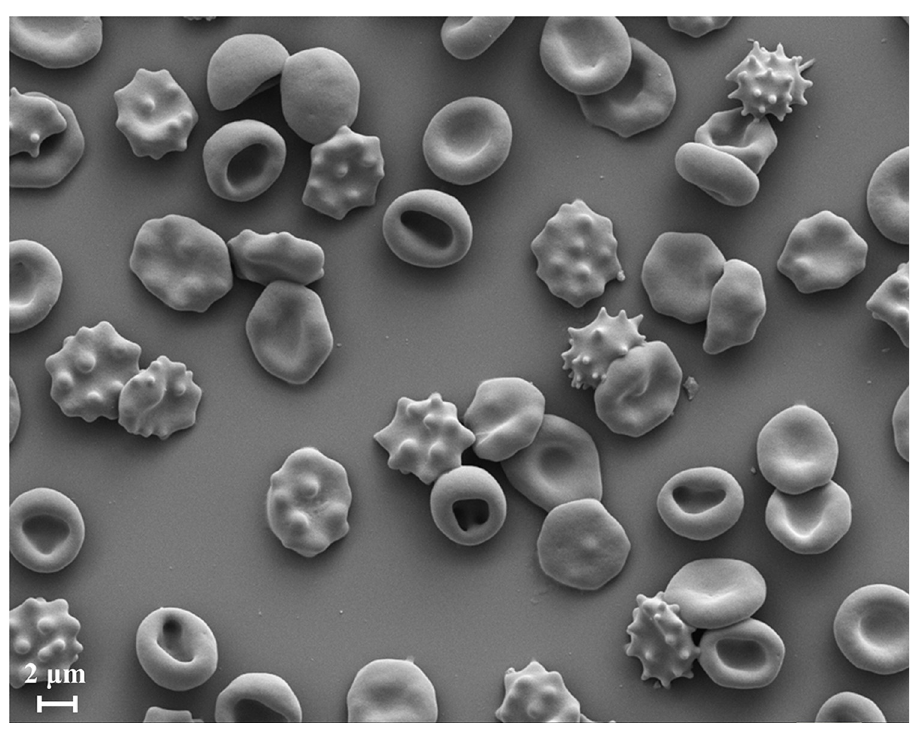
Fig 1. Scanning electron microscope (SEM) image of a RBC population having different morphology stages of stomatocytosis and echinocytosis.